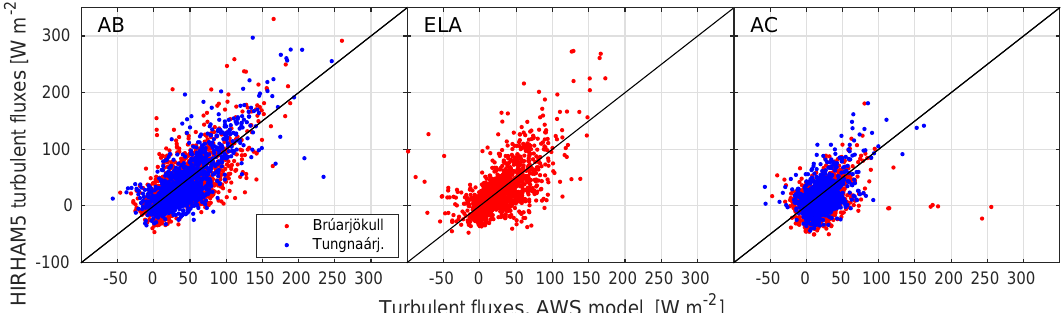
Figure 5. The total turbulent fluxes calculated from AWS stations using the one-level flux model versus the HIRHAM5 simulated values.